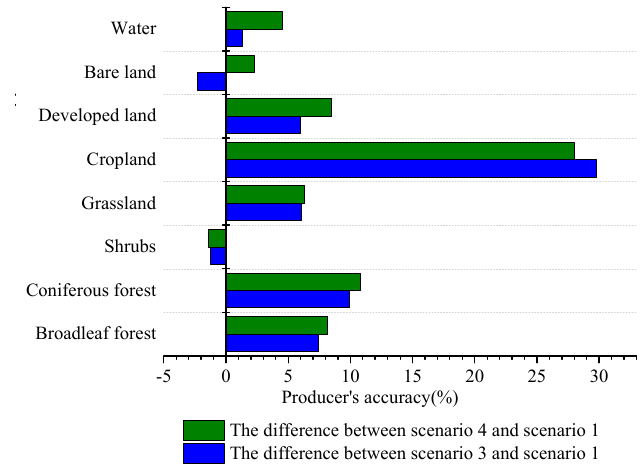
Figure 8. The differences of producer’s accuracy between scenarios.